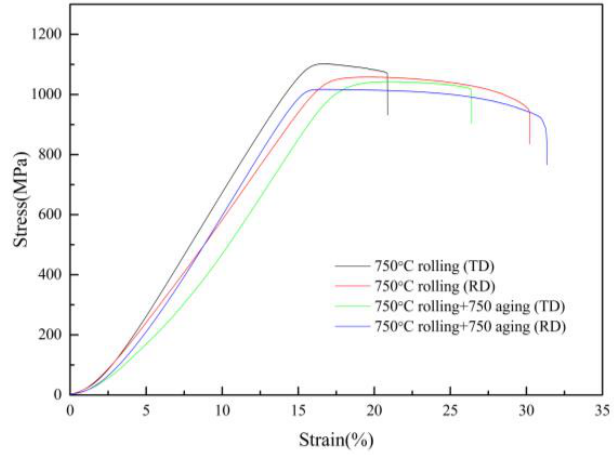
Figure 2. Room temperature engineering stress-strain curves of different samples.